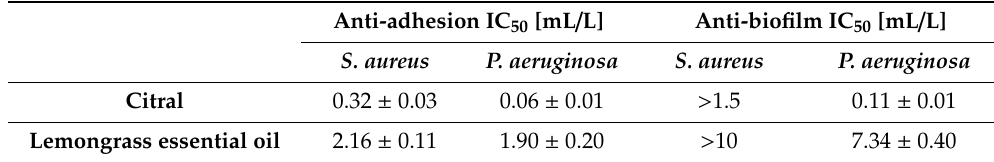
Table 3. Concentration of citral and lemongrass essential oil that halves the respective activity: (i) adhesion of bacteria forming biofilm and (ii) mature